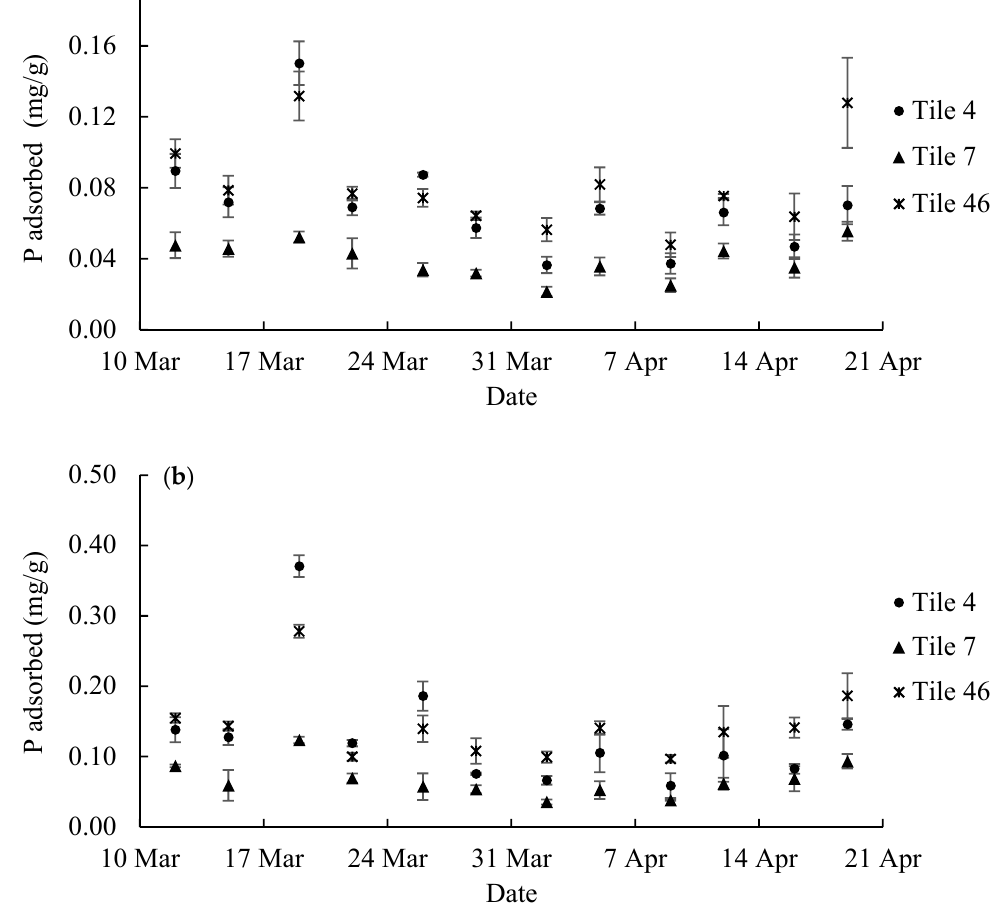
Figure 5. Phosphate adsorption in the hybrid resin ( a ) HR1 and ( b ) HR2 from the three tile lines in each sampling period in 2020.